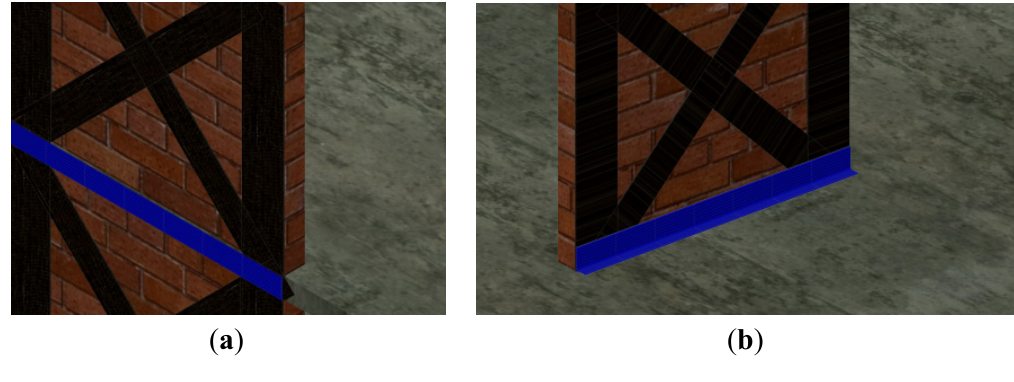
Figure 11. Implementation of mechanical anchorage ( a ) for exterior walls and ( b ) for interior